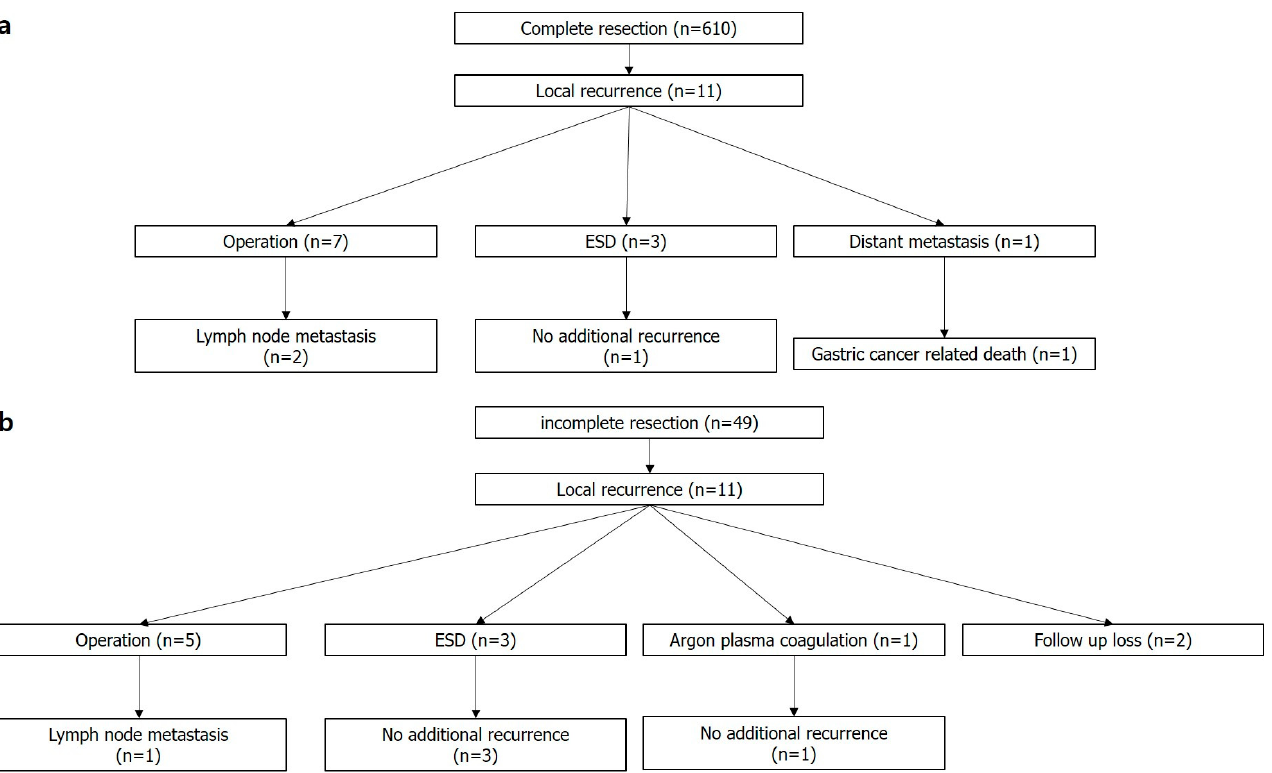
Figure 4. Clinical outcomes of patients with locally recurrent lesions. ( a ) Complete resection, ( b ) Incomplete resection. ESD, endoscopic submucosal dissection; n, number.